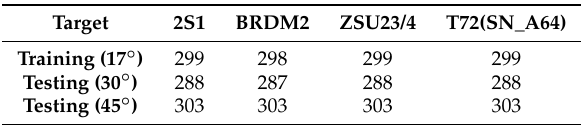
Table 2. The number of images for training and testing about the four targets under extended operating conditions (EOC).